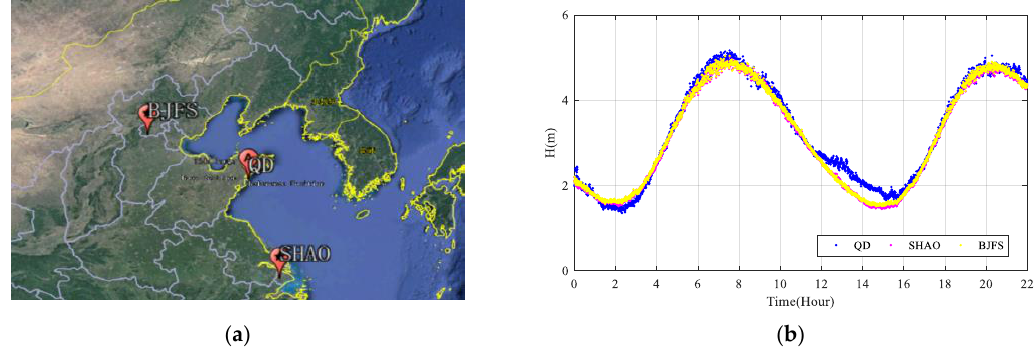
Figure 11. The instantaneous sea level comparation of the DD method using three different base stations. ( a ) Shows IGS stations BJFS, SHAO and our reference station QD, ( b ) shows the three DD results without outlies of the instantaneous sea level with different base stations. Table 4. Cross-validation of DD instantaneous sea level using three different base stations.